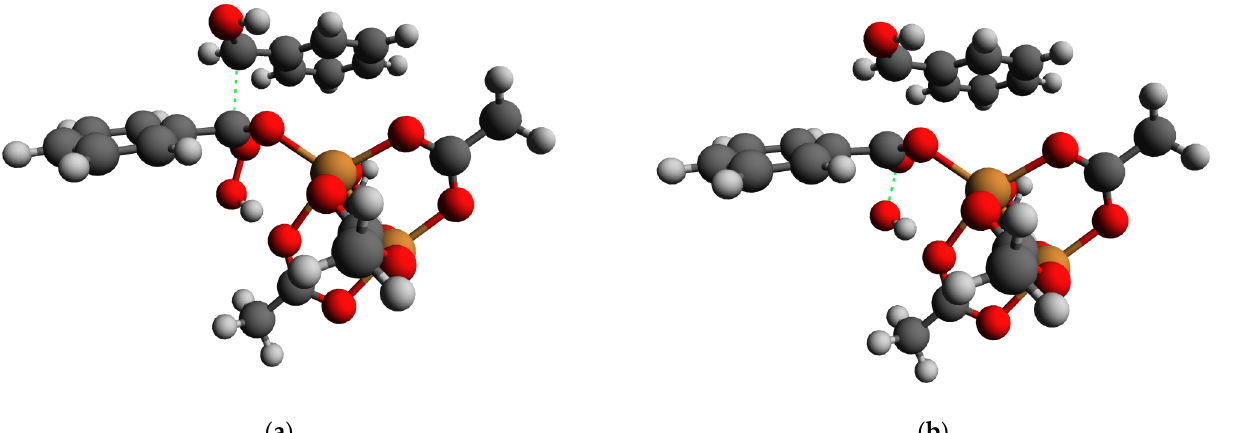
Figure 17. ( a ) The geometry of the transition state of the Baeyer–Villiger reaction pathway of the benzoin oxidation estimated by the NEB climbing image; ( b ) the image representing the result of the O–O bond cleavage. Orange: Cu, red: O; dark grey: C; light grey: H. Green dotted lines indicate positions of broken bonds.